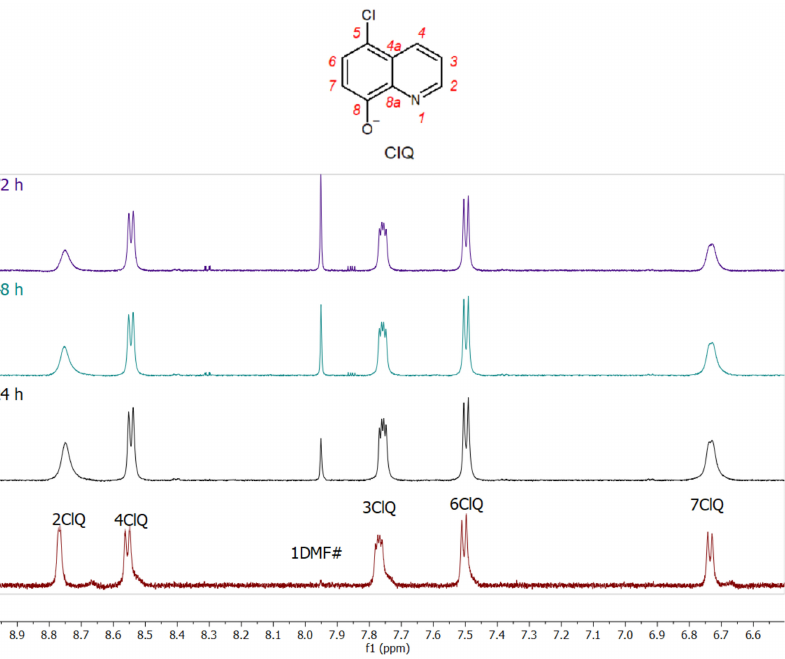
Figure 4. Time-dependent 1 H NMR (600 MHz, DMSO-d6) spectra of complex 1